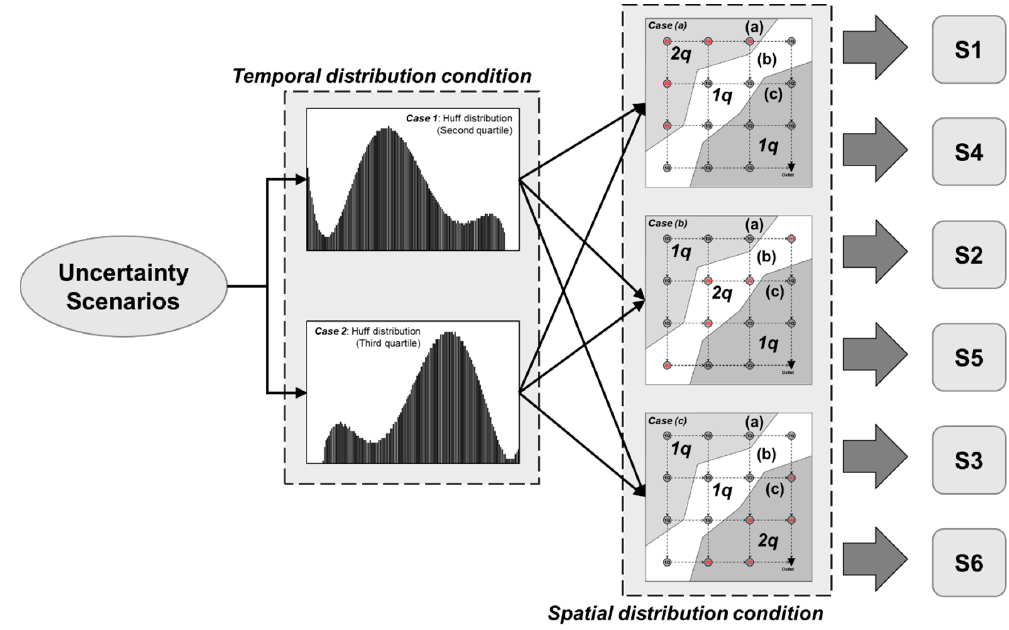
Figure 3. Schematic of future scenarios based on uncertainty factors.